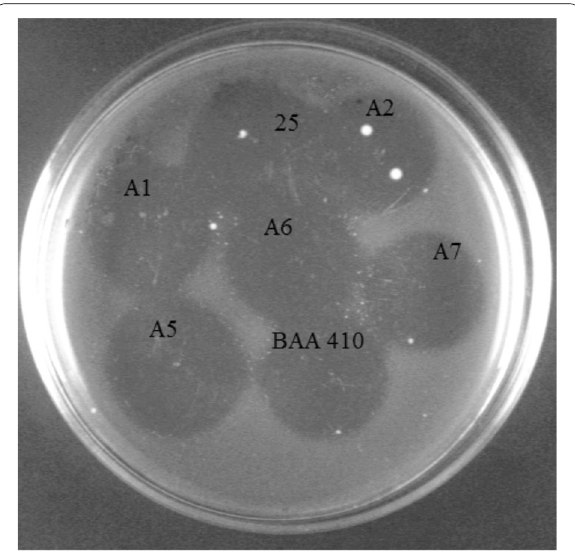
Fig. 2 Lytic zones (plaques) of the lysogenic Myoviridae phages specific for M. haemolytica